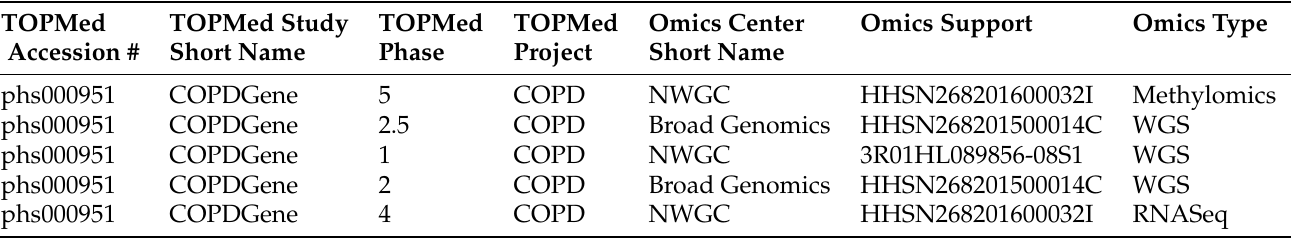
Table A1. TOPMed Omics Support Table. Broad Genomics = Broad Institute Genomics Platform. NWGC = Northwest Genomics